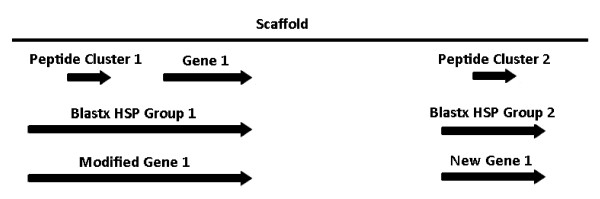
Peptide clusters which did not confirm an existing gene model or conflict with an existing gene model in the opposing orientation were compared to grouped blastx HSPs from related dothideomycete proteins. Some of these peptide clusters were linked back to existing gene models as illustrated by Peptide Cluster 1 and Gene 1, which share a homology relationship with Blastx HSP group 1. This provides strong evidence for the reannotation of Gene 1 to become Modified Gene 1. Other peptide clusters could not be linked to existing gene annotations such as Peptide Cluster 2, which provides evidence for the creation of New Gene 2.